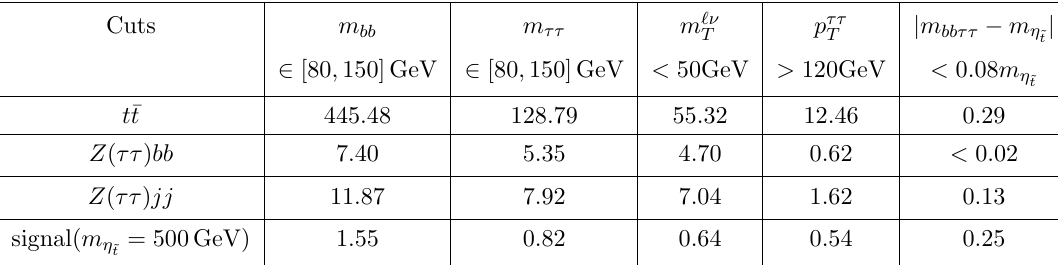
Table 1 . Cut (cid:13)ow analysis of the cross sections (fb) for the signal and backgrounds at 14 TeV LHC. The benchmark point is chosen as m (cid:17)